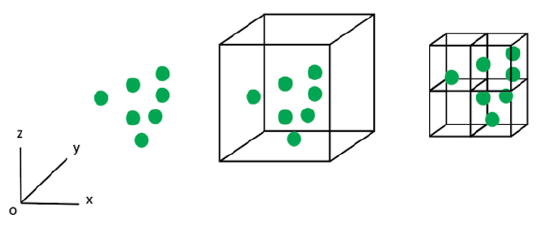
Figure 2. The impact of voxel size on point cloud voxelisation shrubs and mallee. Voxel sizes of 0.4 m, 0.6 m, 1.0 m, 1.2 m and 1.6 m are experimented on the dataset to explore the influence of the different voxel